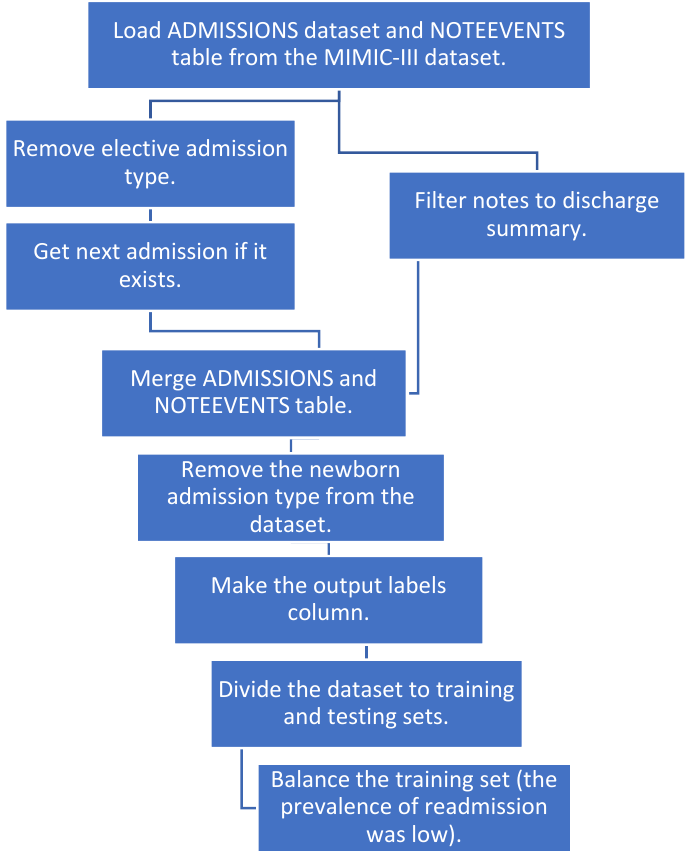
Figure 1. The pipeline for data